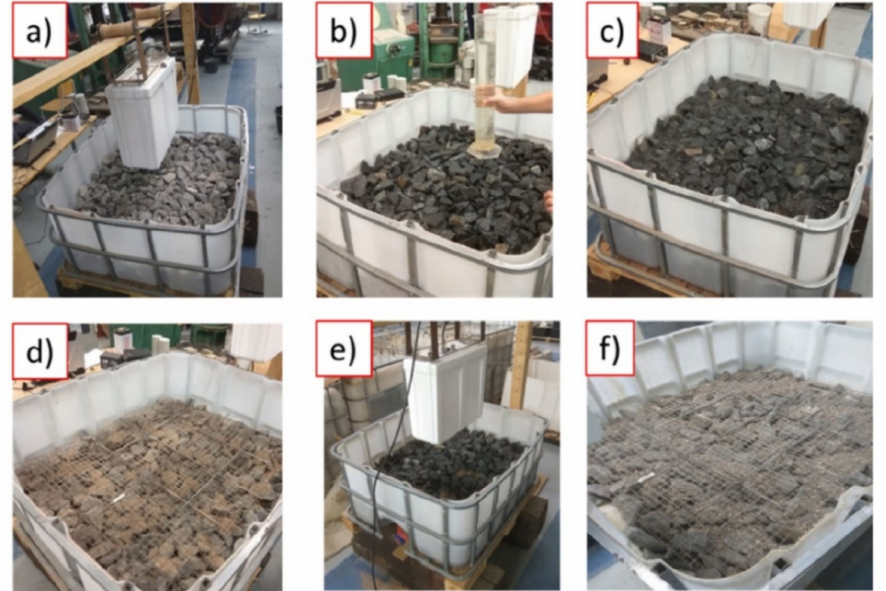
Figure 10. ( a – f ) demonstrate the whole testing procedure, including test set-up, test conditions and GPR positions. Test configurations of ballast box with ballast particles and fouling (figure reproduced from